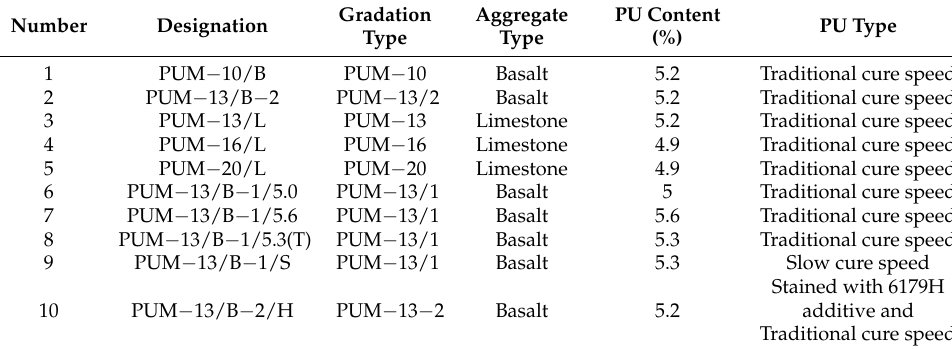
Table 1. The mixture gradation design combinations.